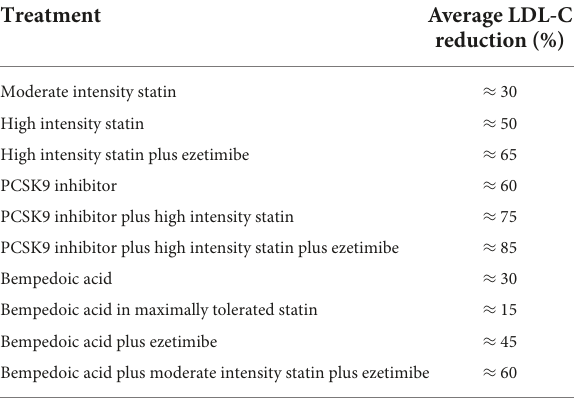
TABLE 1 Effectiveness of cholesterol-lowering